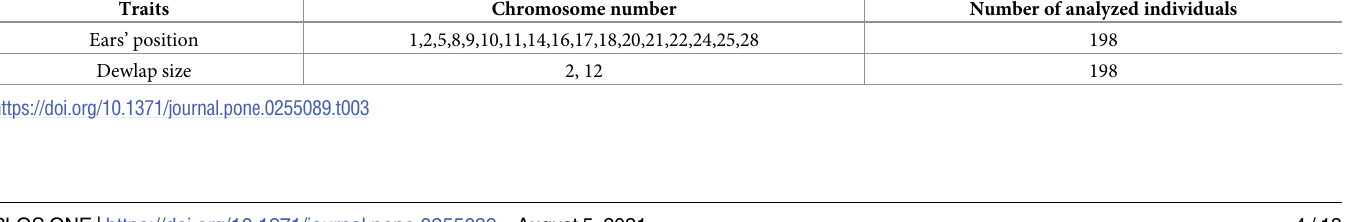
Table 3. Chromosomes with significant effects for qualitative traits.